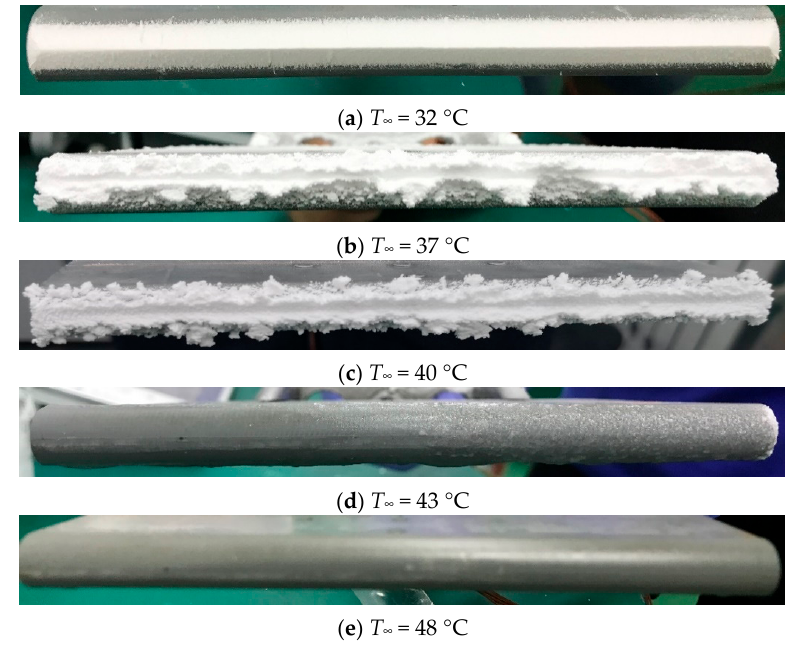
Figure 14. Photographs of wax deposition on leading edge with different mainstream temperature.